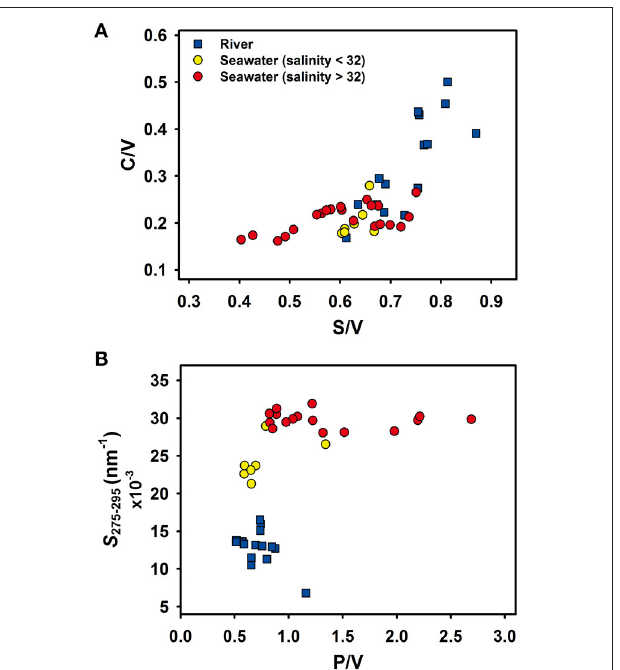
FIGURE 4 | Scatter plots of lignin phenol compositions (A) S/V ratio vs. C/V ratio, (B) P/V ratio vs. spectral slope S 275 – 295 in river (blue squares) and surface waters (yellow and red circles).